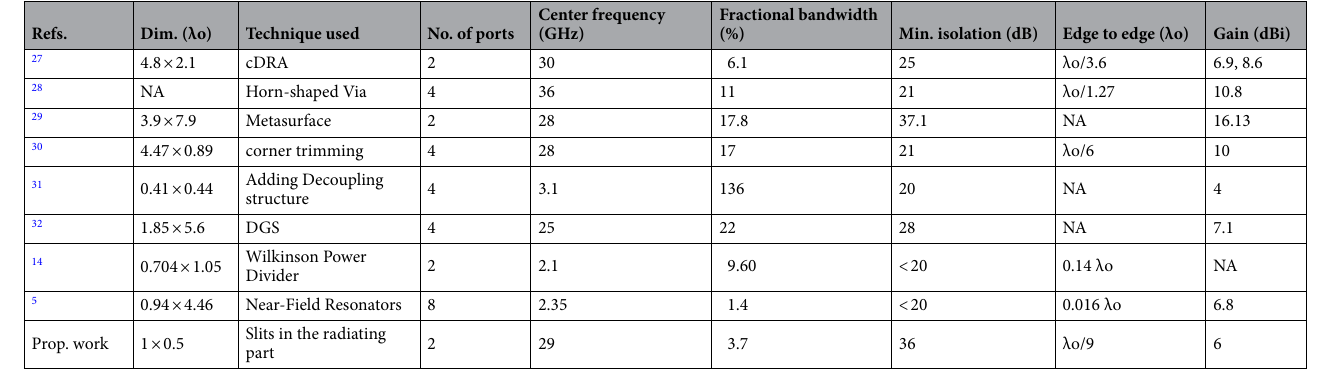
Table 1. Performance comparison with recent state of the art in the